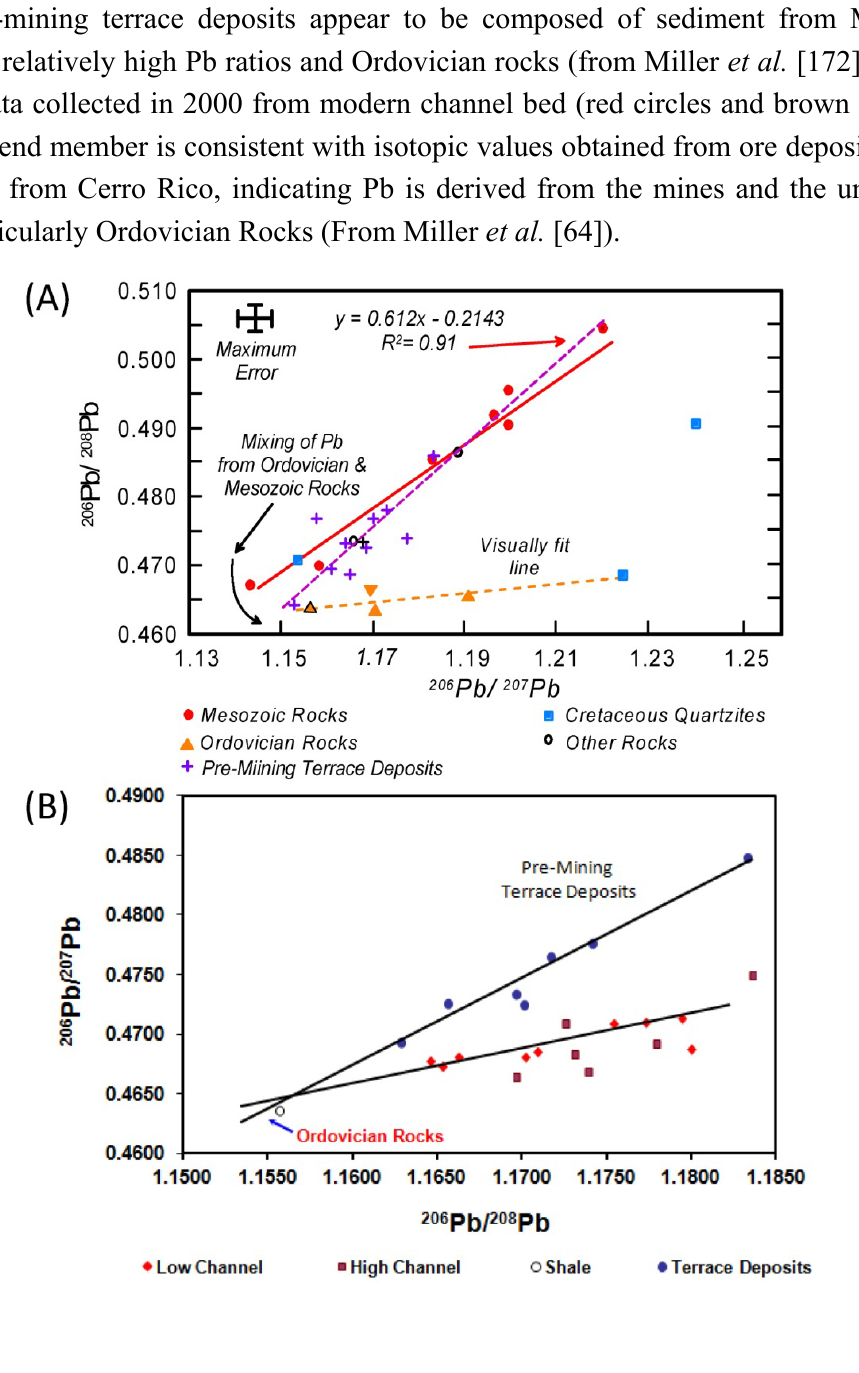
Figure 9. ( A ) Pb isotopic ratios measured in pre-mining (and uncontaminated) terrace deposits (purple line) vs. those measured within Ordovician, Mesozoic and Cretaceous rocks. Pre-mining terrace deposits appear to be composed of sediment from Mesozoic rocks with relatively high Pb ratios and Ordovician rocks (from Miller et al. [172]). ( B ) Pb Isotopic data collected in 2000 from modern channel bed (red circles and brown